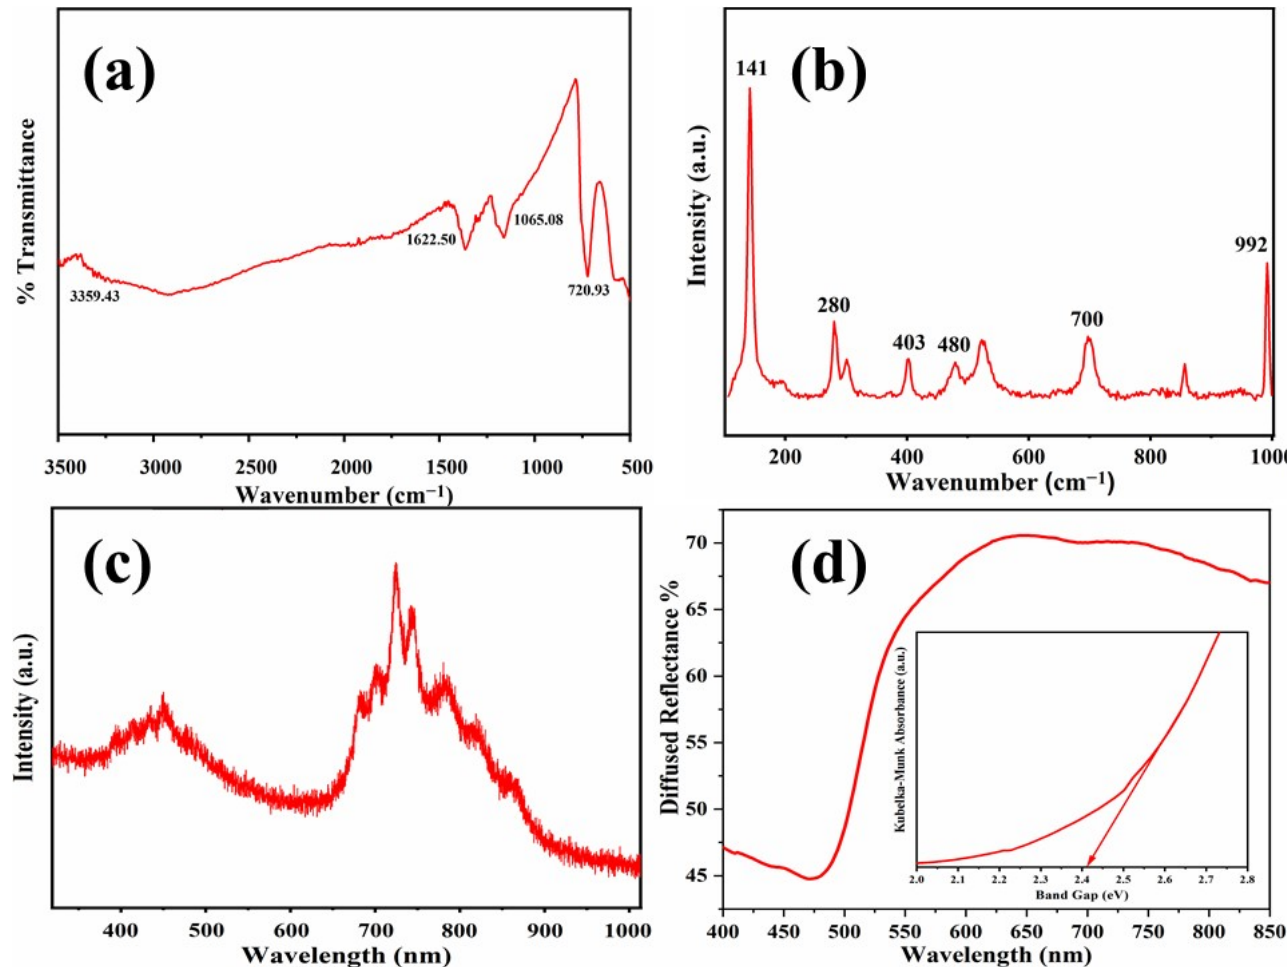
Figure 1. FT-IR ( a ), Raman ( b ), PL ( c ) and UV-Vis DRS ( d ) spectrum for micro-spherical V 2 O 5 photocatalyst. The Raman spectroscopy was carried out in a wavelength range from 100 to 1000 cm − 1 for V 2 O 5, as shown in Figure 1b. The prevailing band at 141 cm − 1 was related to V-O- V vibrations, and its presence reveals the microstructure of V 2 O 5 . The band that appeared at 992 cm − 1 communicates to the stretching mode of terminal oxygen (V +5 =O), which is related to the crystallinity of structure [34]. The band at 700 cm − 1 is allotted to the stretch- ing mode of doubly coordinated oxygen (V 2 -O) due to corner shared oxygen. The small band at 480 cm − 1 is allotted to V-O-V bridging and V 3 -O bonds in a triply coordinated oxygen system [35]. The prominent bands positioned at 403 and 280 cm − 1 are delegated to the bending vibrations of V–O bonds [36]. Figure 1c reveals the PL spectra of the V 2 O 5 nanostructure. The PL band shows two peaks positioned around 400–480 nm and 650–850 nm. The peak around 400–480 nm is initiated by the transition from the top of the conduction band to the valance band. The emission band at 650–850 nm is an extrinsic transition produced by oxygen vacancies due to the calcination process. The PL spectrum intensifies due to the reorganization of the structure when calcination at elevated temperature [37]. The diffuse reflectance spectrum (DRS) of as-synthesized V 2 O 5 is shown in Figure 1d. Pure V 2 O 5 shows broad absorption in the visible light region [38] and displays a strong absorption band at 500 nm [36]. The peak at the beginning of the visible spectrum at about 400 to 500 nm suggests that as-synthesized V 2 O 5 can be used as an efficient photocatalyst concealing the visible range [39]. The optical bandgap of V 2 O 5 was intended to be 2.41 eV using Tauc’s plot presented in the inset of Figure 1d.